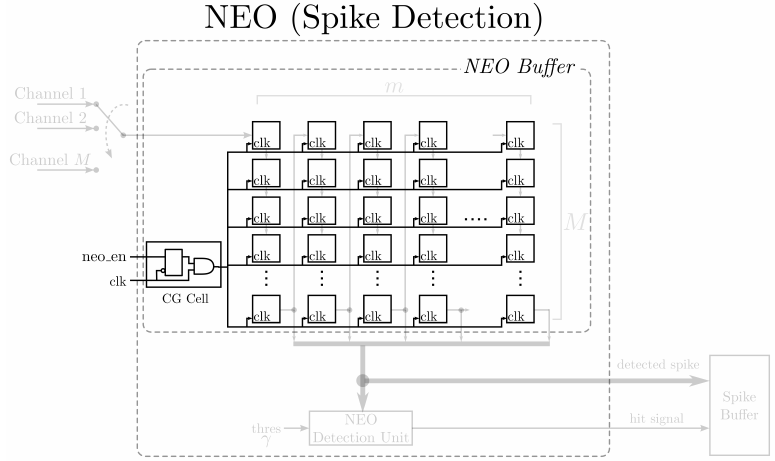
Figure 3. The clock gating circuit for lowering the dynamic power consumption of the NEO circuit for spike